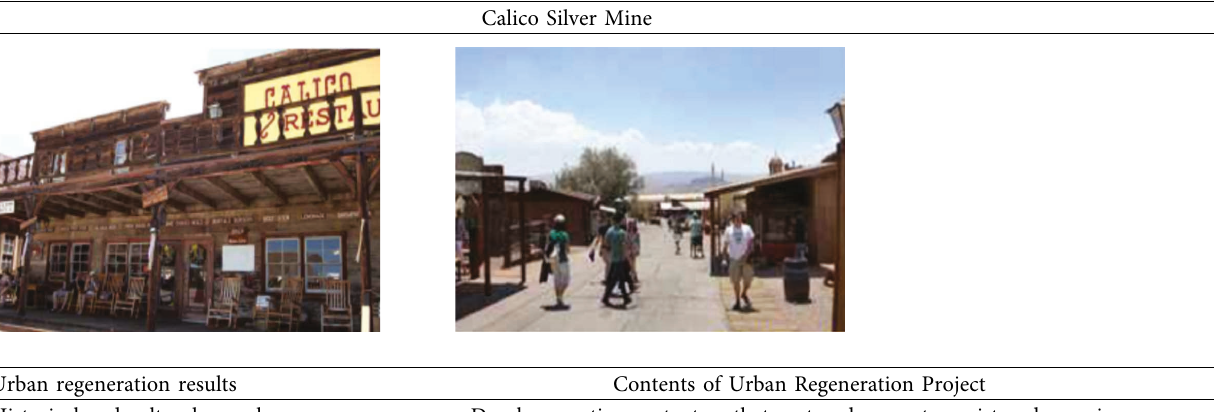
Table 7: Result of urban regeneration in Calico Silver Mine, the United